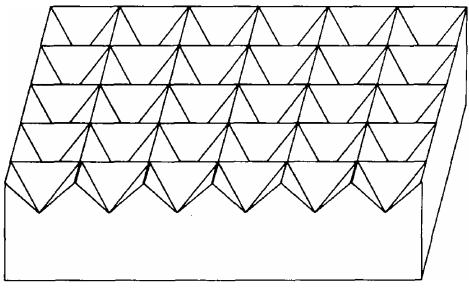
Figure 19. The inverted pyramids geometry utilized for light trapping on Si solar cells